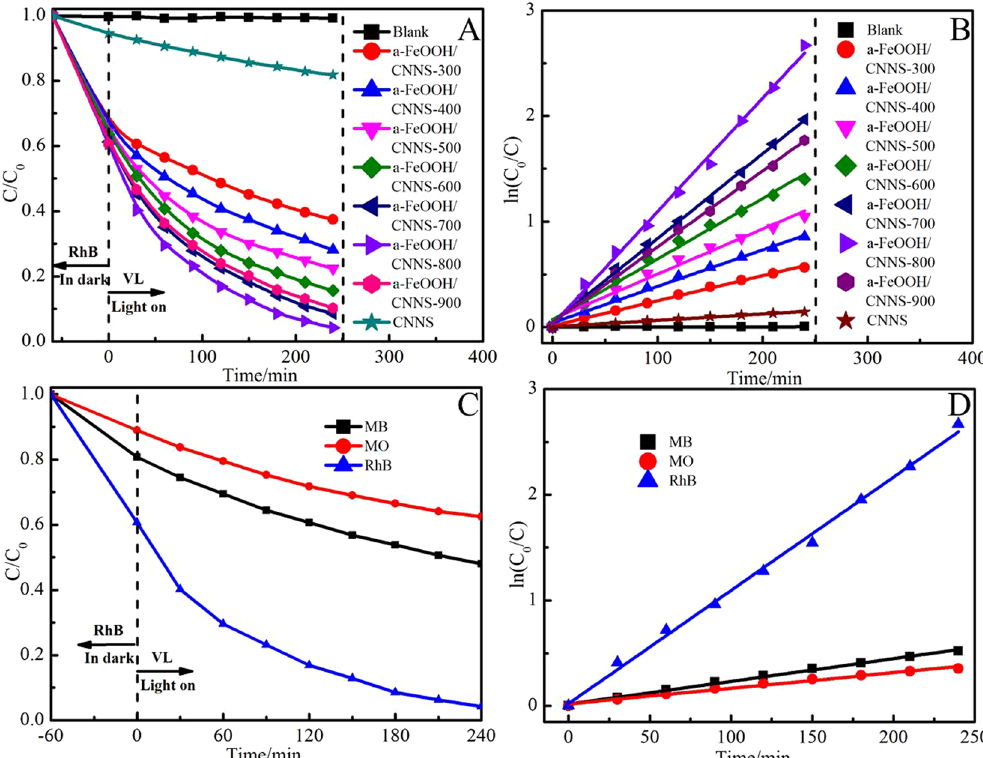
Figure 9. ( A ) The photocatalytic activities of the as-prepared photocatalysts for the degradation of RhB under visible light irradiation; ( B ) The rate constants of the as-prepared photocatalysts for the degradation of RhB; ( C ) The photocatalytic activities of the as-prepared photocatalysts for the degradation of RhB, MB, MO under visible light irradiation; ( D ) The rate constants of the as-prepared photocatalysts for the degradation of RhB, MB, MO.